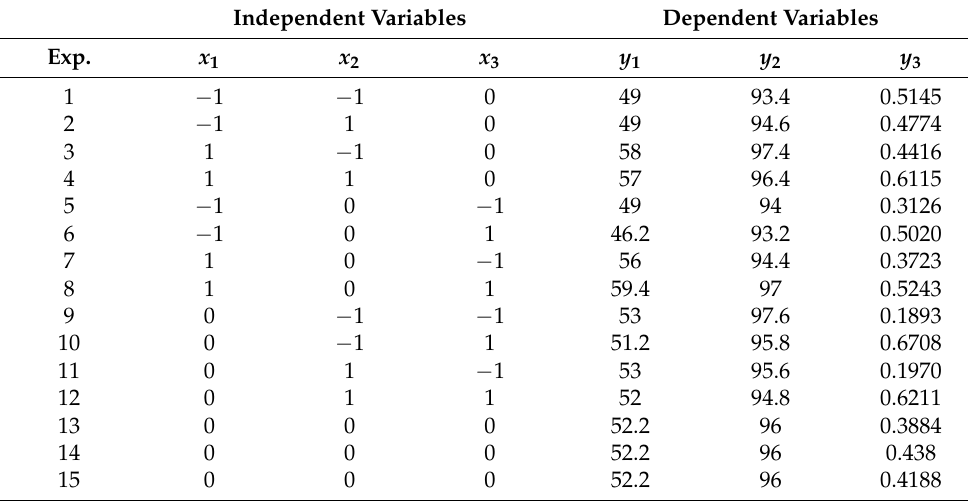
Table 3. Operational conditions considered in this study (expressed in terms of the coded inde- pendent variables: dimensionless resin × 1; dimensionless thickener × 2; and dimensionless PCM × 3). Experimental results achieved for the dependent variables: y1 (Shore D hardness); y2 (Shore A hardness); and y3 (absorbed heat after